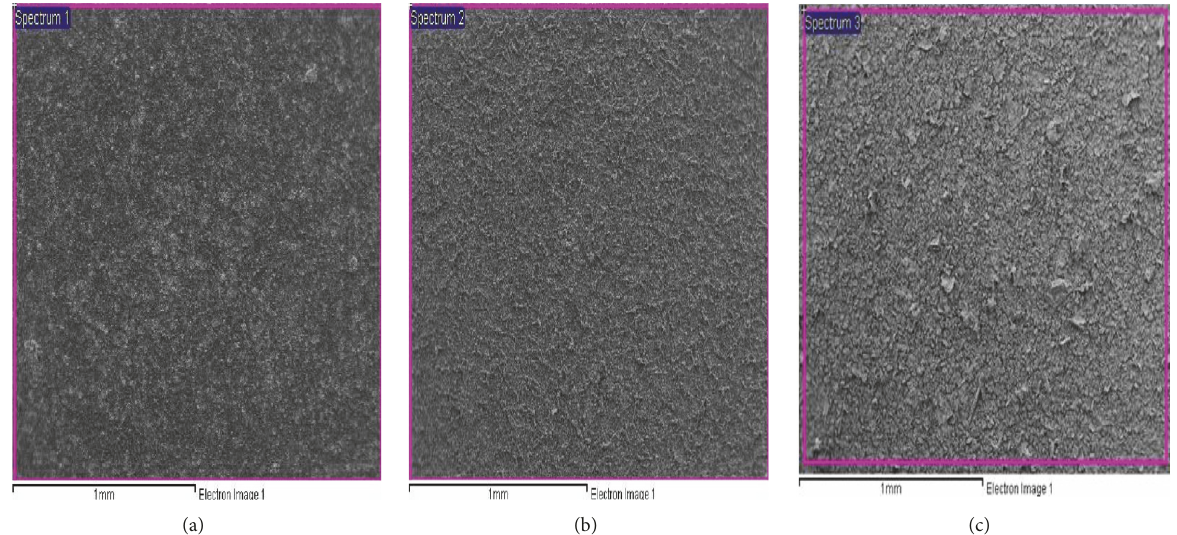
Figure 6: Surface evaluation by SEM micrograph. (a) Control, (b) treatment (GTE); and (c) treatment with turmeric (TE) with green tea.